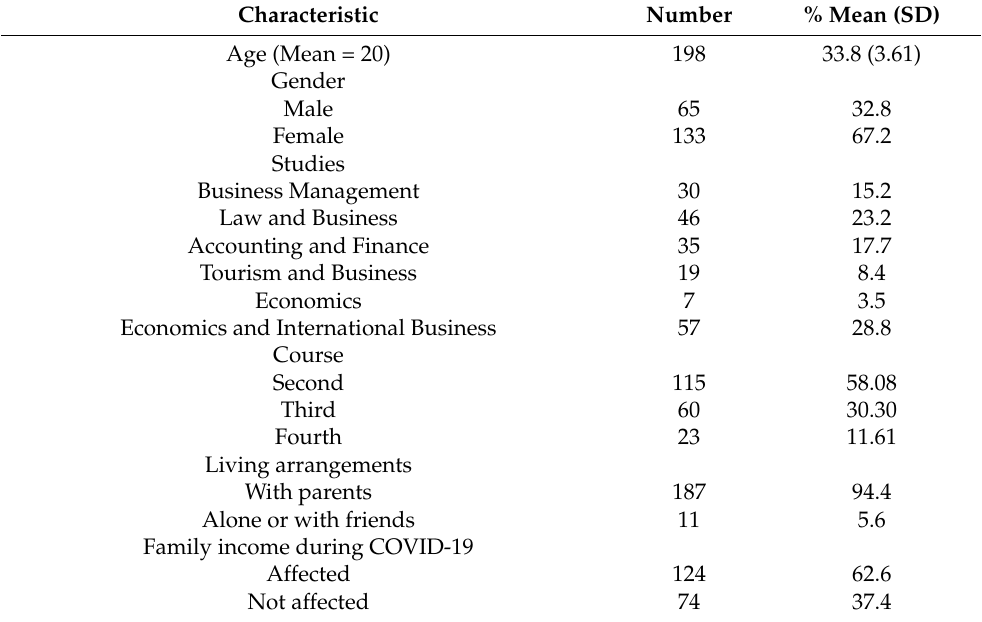
Table 1. Demographic and living